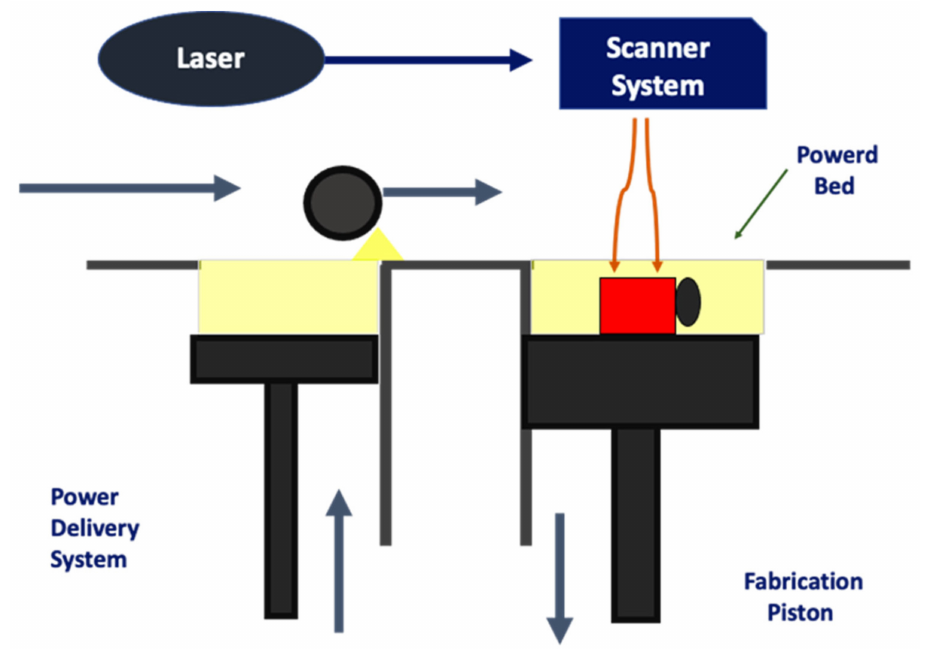
Figure 9. Selective Laser Sintering